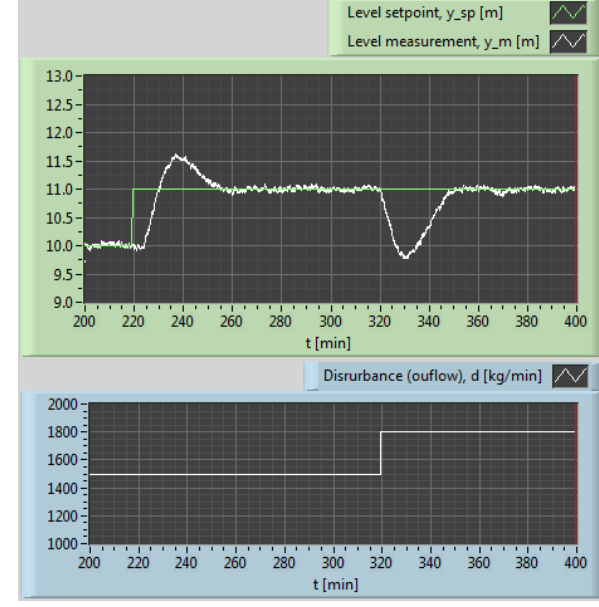
Figure 12: Responses in the level control system with Good Gain